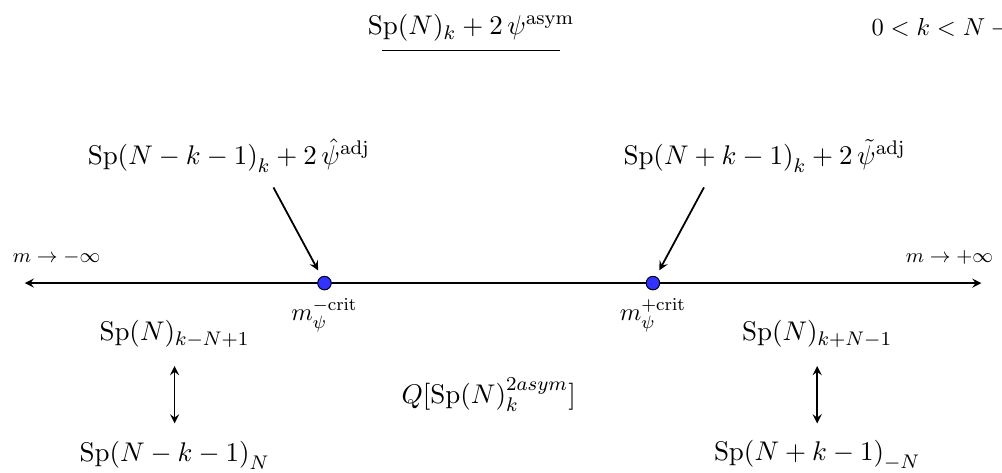
Figure 13 . Phase diagram of Sp( N ) with two antisymmetric-traceless fermions for 0 < k < N (cid:0) 1. The right dual description is always strongly coupled and left dual description is weakly coupled only when N= 2 (cid:20) k < N (cid:0)